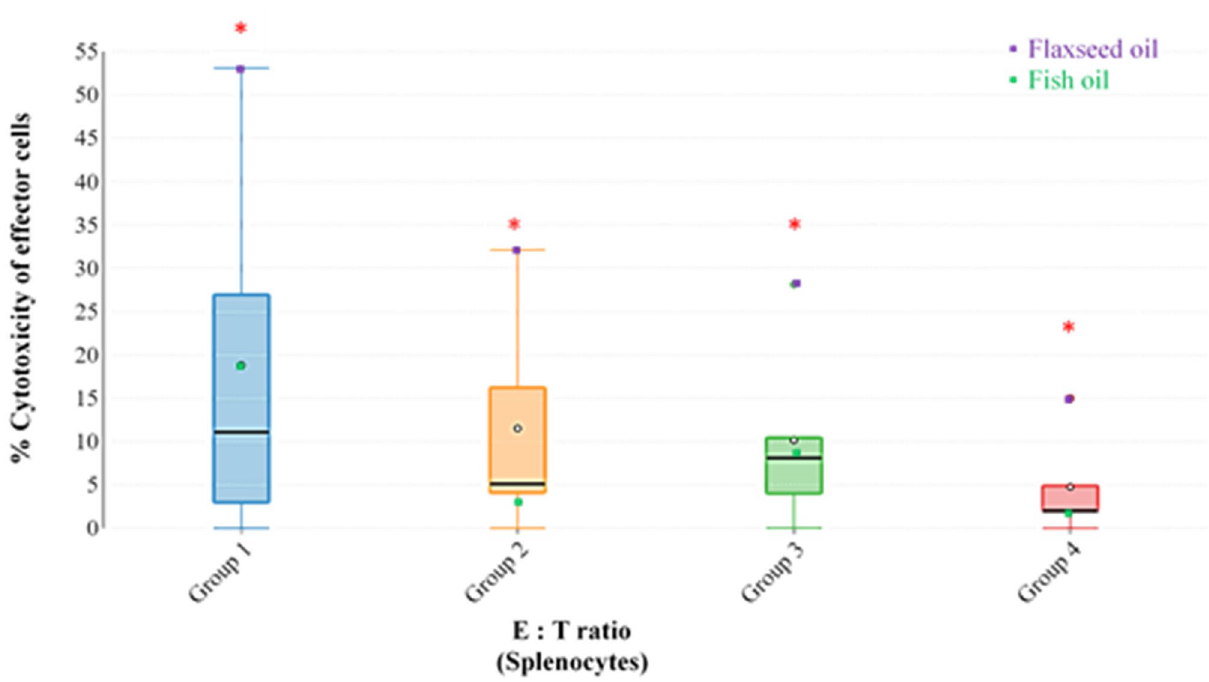
4: E:T ratio of 12.5:1; only statistically significant results obtained from one-way ANOVA are represented by red asterisks (P ≤